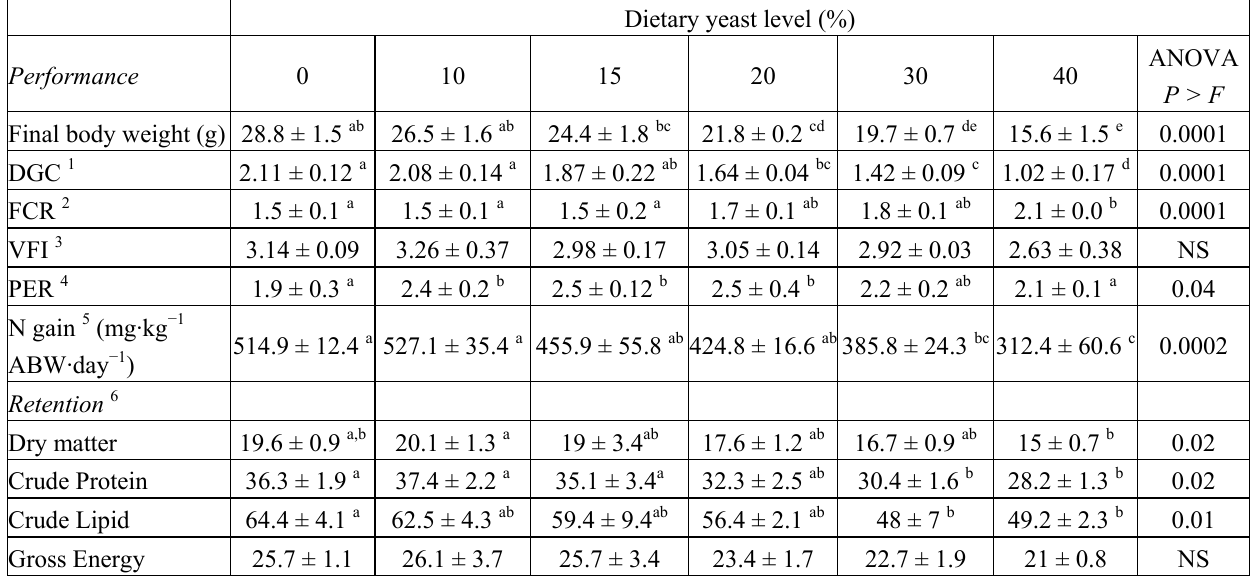
Table 2. Effect of different dietary yeast levels on weight gain, feed efficiency and nutrient utilization in juvenile tilapia (initial weight = 7.6 ± 0.3 g) fed over 51 days.